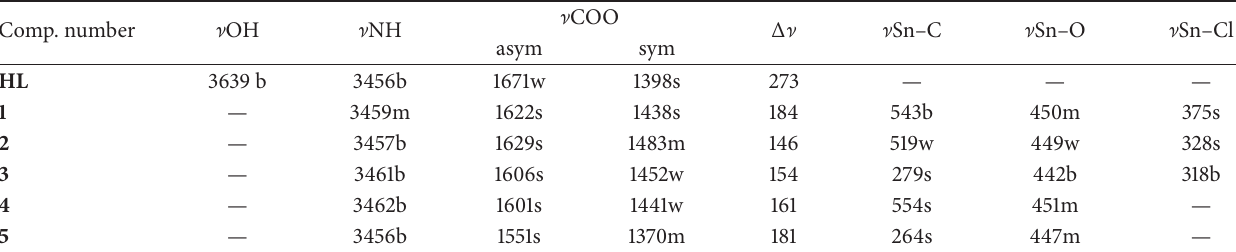
Table 2: IR data a (cm − 1 ) of organotin(IV) complexes 1–5 .